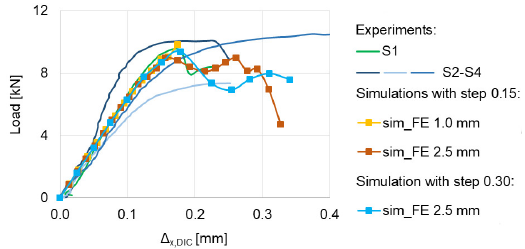
Figure 9. The effect of element size and load step size on calculated response in the shear test